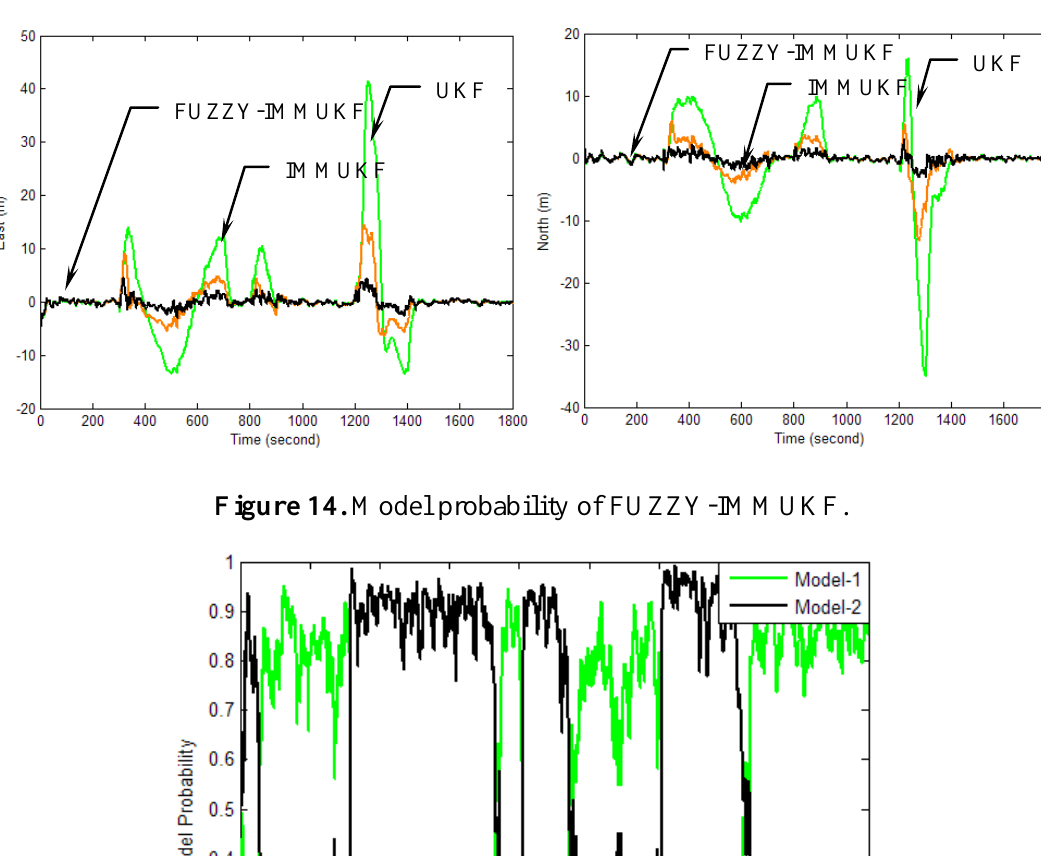
Figure 13. Comparison of the navigation accuracy for three approaches: FUZZY-IMMUKF, IMMUKF and UKF.